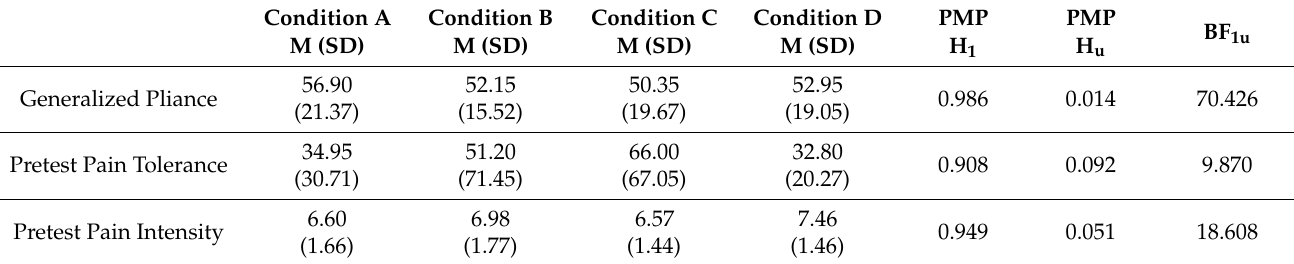
Table 1. Descriptive data for each condition at pretest and BAIN one-way ANOVA